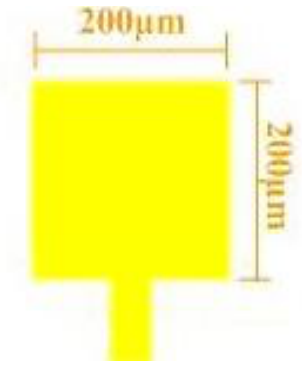
Figure 2. Design of a micro voltage